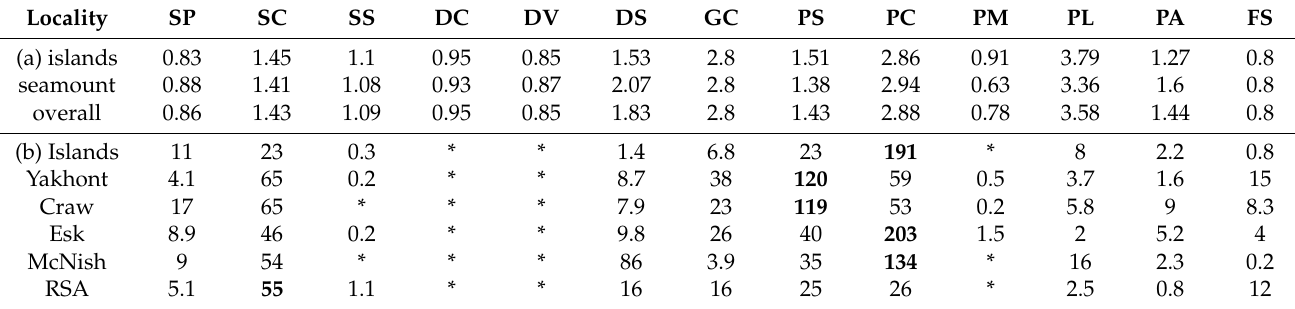
Table 3. Zoobenthic carbon storage (stock) by functional group and locality <1000 m depth. The data are: mean mass g carbon; (a) per individual and zoobenthic carbon g/m 2 = t/km 2 , (b) by functional group and locality. The Tristan da Cunha archipelago localities are as in Table 1. Values of 0.1 or less are indicated by *. The dominant functional group (by mass) for each area is shown in bold.